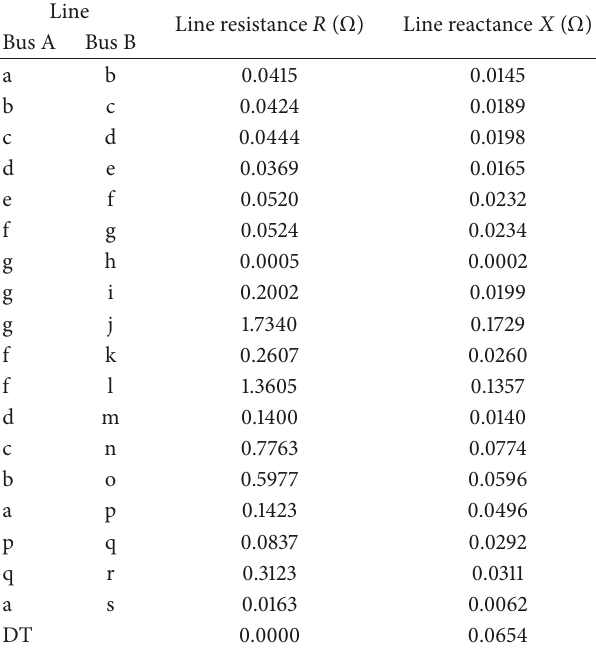
Table 1: Line data for 415V